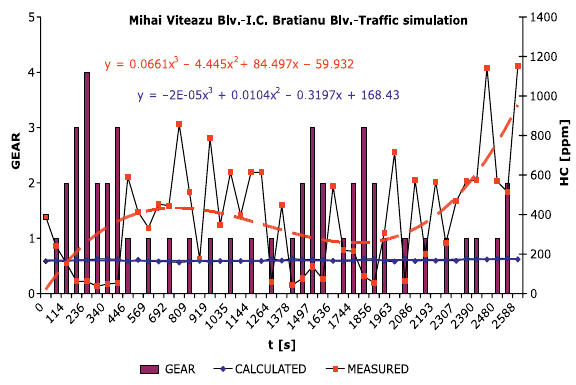
Fig. 8. HC emission versus time for petrol fuel (air conditioning unit is turned off)